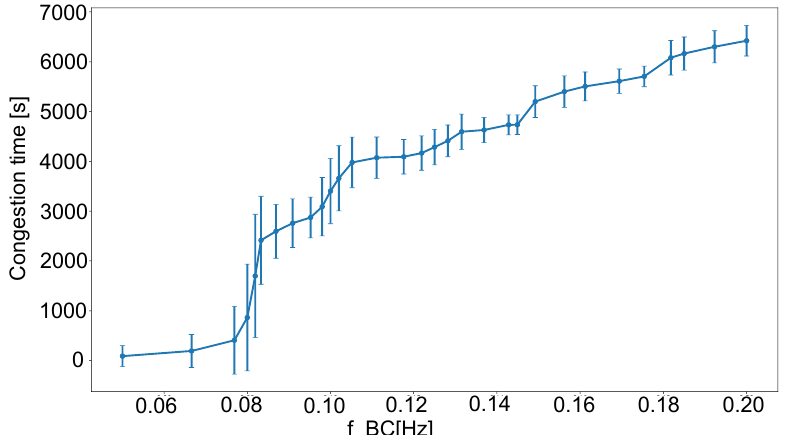
Figure 19. Time point to congestion in the game for different frequencies of transaction